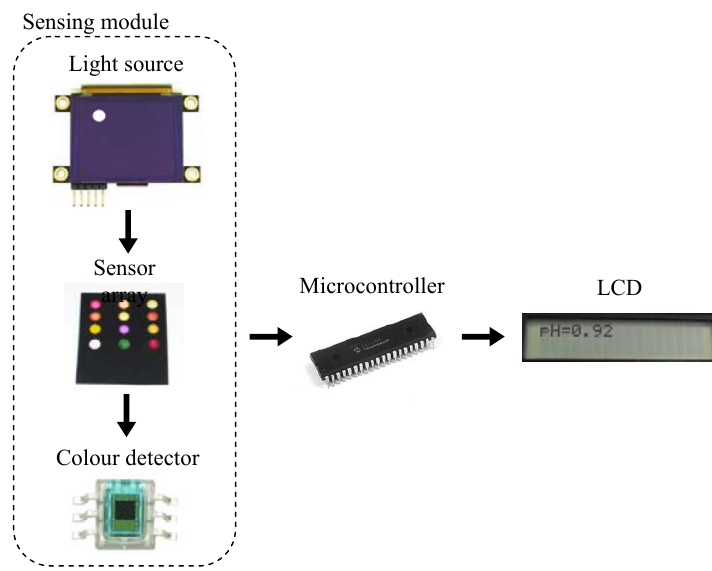
Figure 1. Instrument sensing